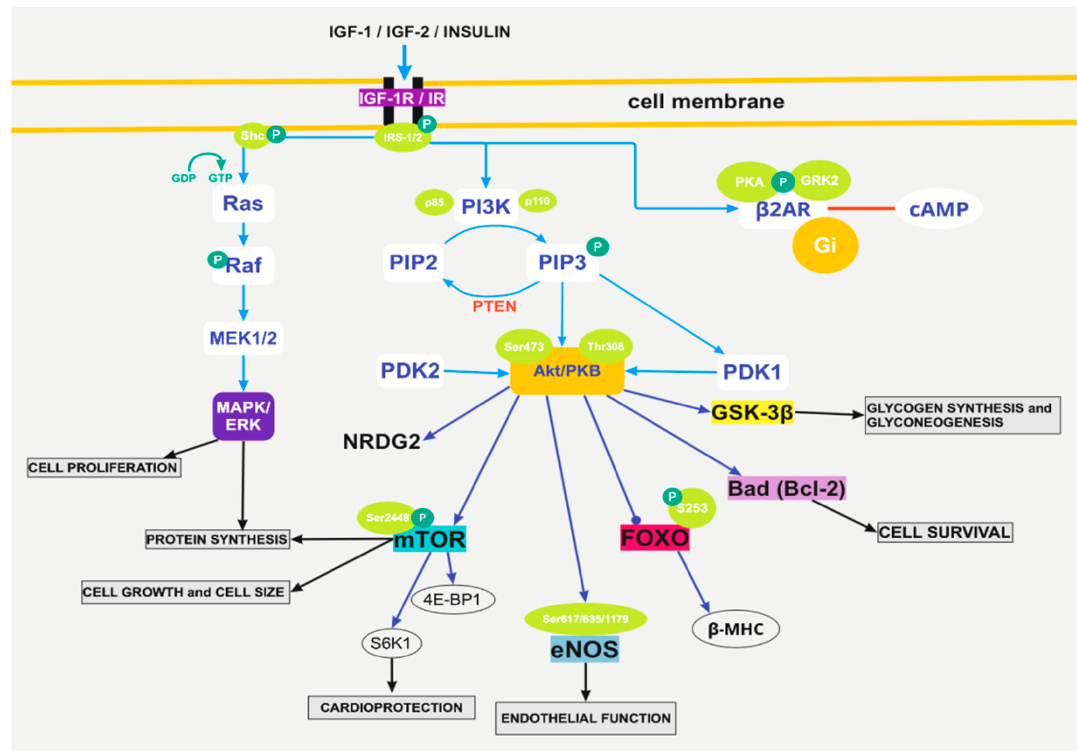
Figure 1. Pathways of insulin signaling in the myocardium. The first step is the activation of the receptors (IGF-1R or IR) by insulin, IGF-1, and IGF-2. All molecules can bind to all receptors, but insulin has a high affinity to the IR, while IGF-1 and IGF-2 have a high affinity to the IGF-1R. After the activation of the receptor, many downstream pathways are subsequently activated, aiming to provide, among others, protein synthesis, cardioprotection, cell growth and size regulation, cell sur- vival, glycogen synthesis, and glyconeogenesis. Abbreviations used: IGF-1: Insulin-like Growth Fac-